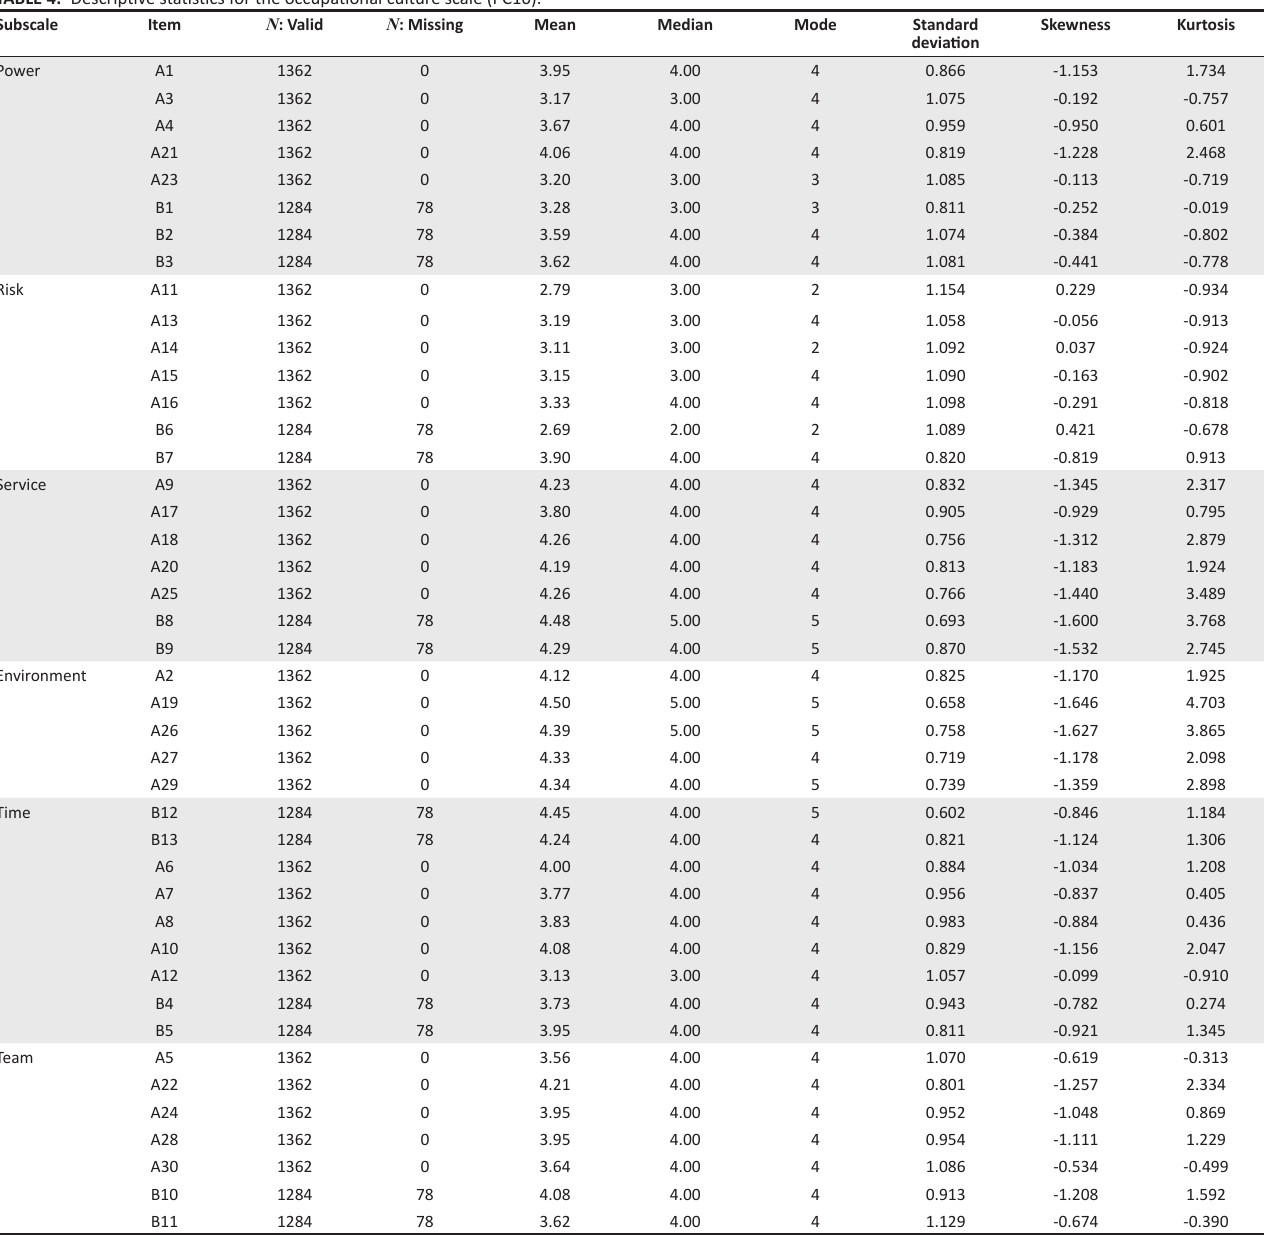
TABLE 4: Descriptive statistics for the occupational culture scale (PC10). Subscale